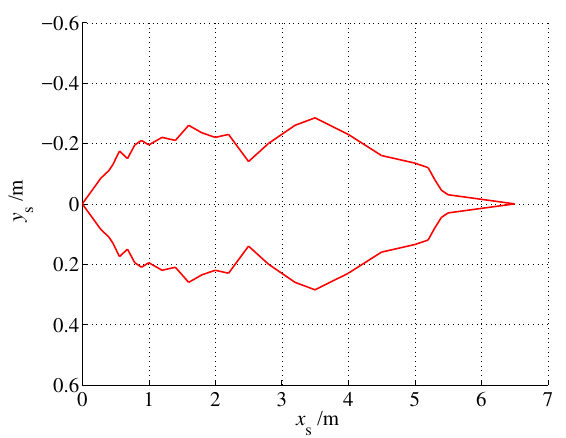
Figure 4. The beam pattern of MaxSonar MB1222 sonar sensor.